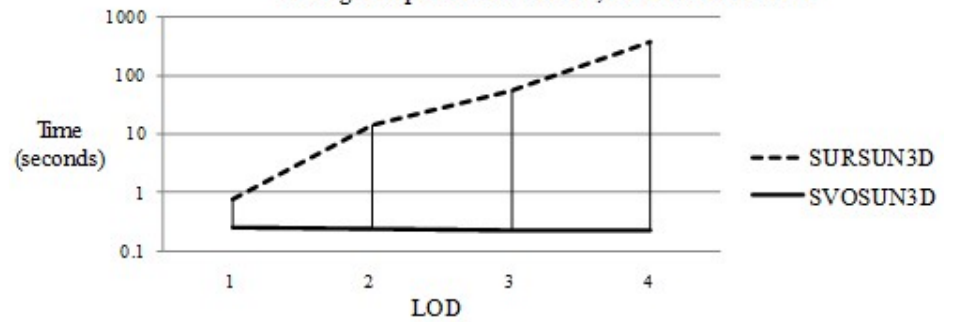
Figure 9. Overall computation efficiency for surface mapping-based 3D solar radiation modeling method (SURFSUN3D) and present model (SVOSUN3D).